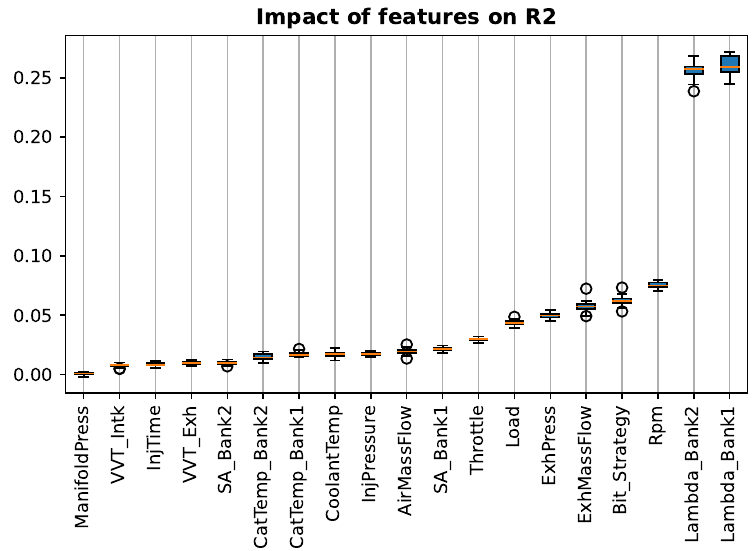
Figure 9. Results of Feature Importance Permutation applied on a subset of ECU